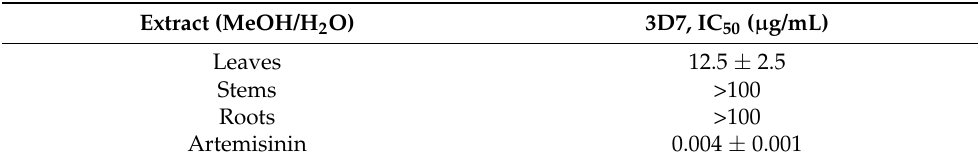
Table 3. Results of the anti-malarial activity of the different extracts obtained by non-sequential extraction (50% inhibition concentration, IC 50 ). Extract (MeOH/H 2 O) 3D7, IC 50 ( µ g/mL) Leaves 12.5 ± 2.5 Stems >100 Roots >100 Artemisinin 0.004 ±